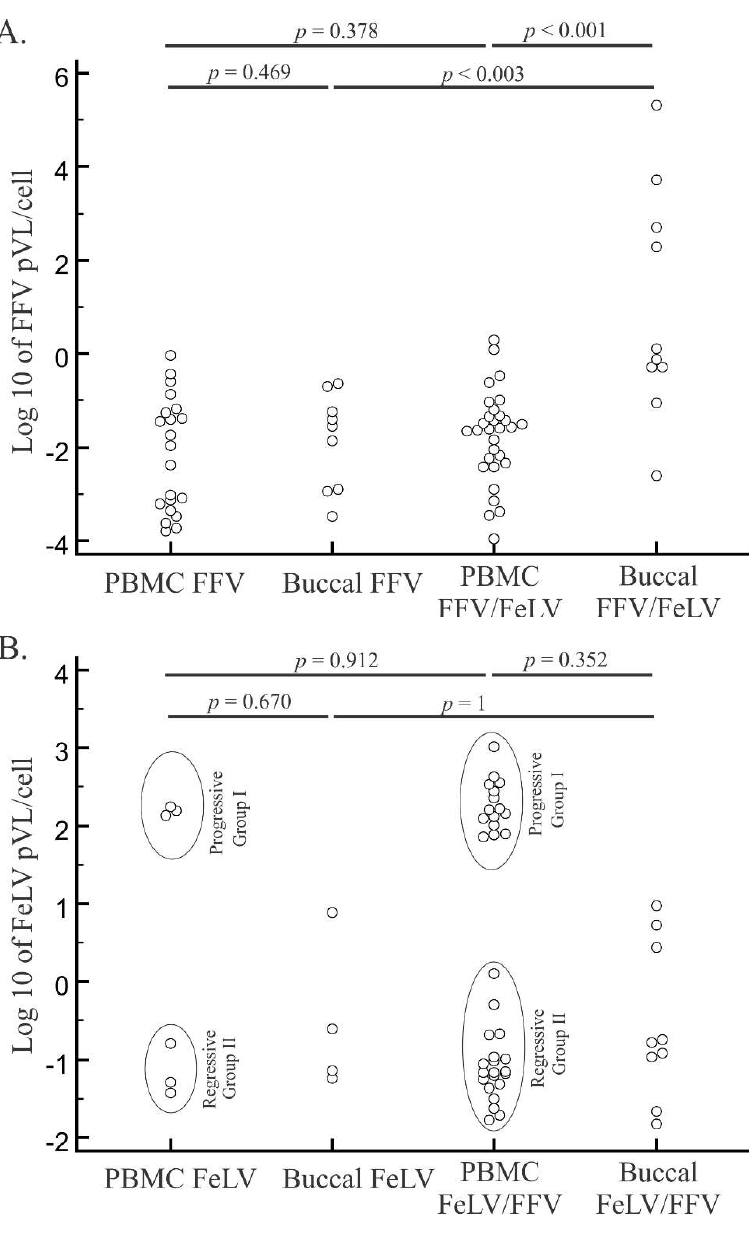
Figure 2. Distribution of feline foamy virus (FFV) and feline leukemia virus (FeLV) log10 proviral loads (pVLs) in blood and oral specimens from singly or dually infected cats. FFV ( A ) and FeLV ( B ) pVLs were measured by quantitative PCR of mono- and co-infected domestic cats from Brazil. Mono- and co-infected cat samples for each retrovirus and in peripheral blood mononuclear cell (PBMC) or buccal specimens are presented. Horizontal lines above each graph depict statistical comparisons between the pVL of specific animal groups or specimen types (Student’s t tests), with associated probability ( p ) values shown. Ellipses in ( B ) represent different groups of FeLV infection outcome (regressive or progressive).